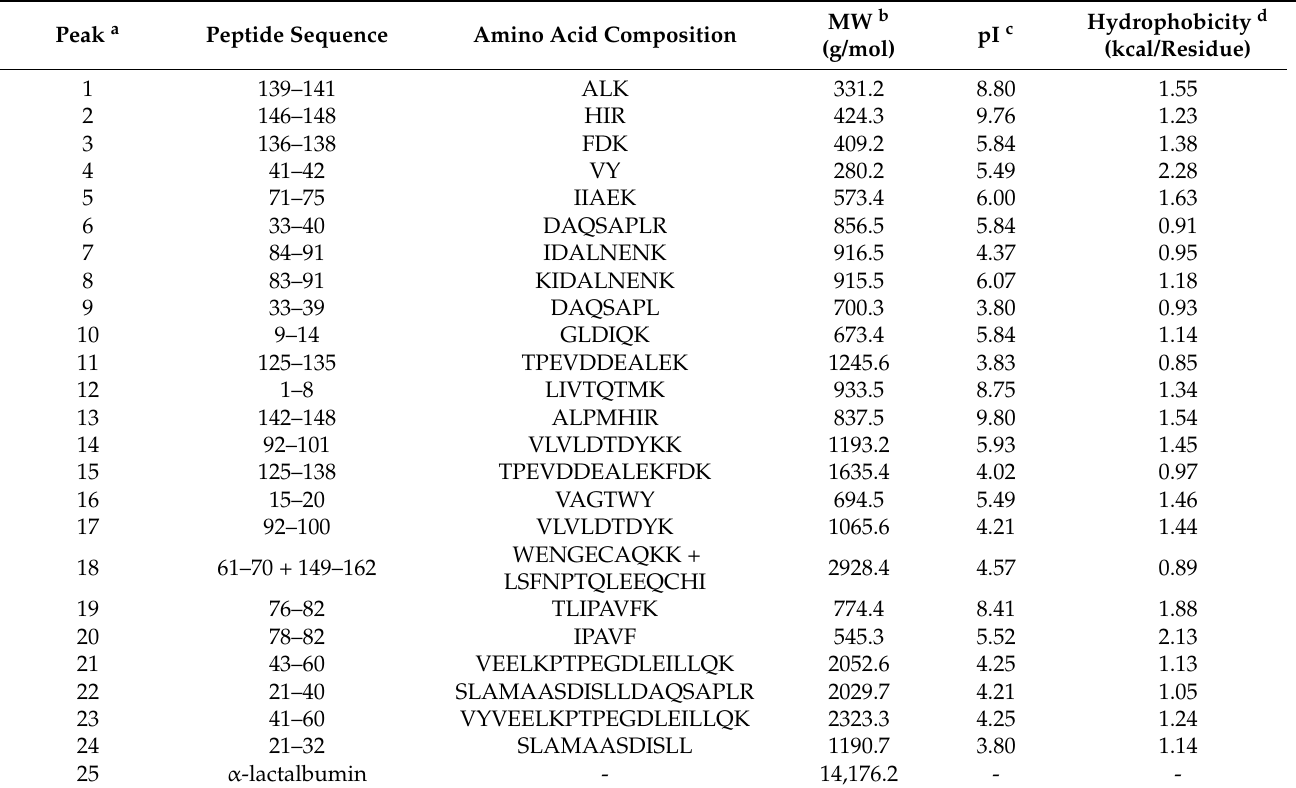
Table 1. Amino acid composition and characteristics of peptides identified in the tryptic hydrolysate and the peptide fractions obtained during filtration (ultrafiltration (UF) and reverse osmosis (RO)) and wash steps. Peak